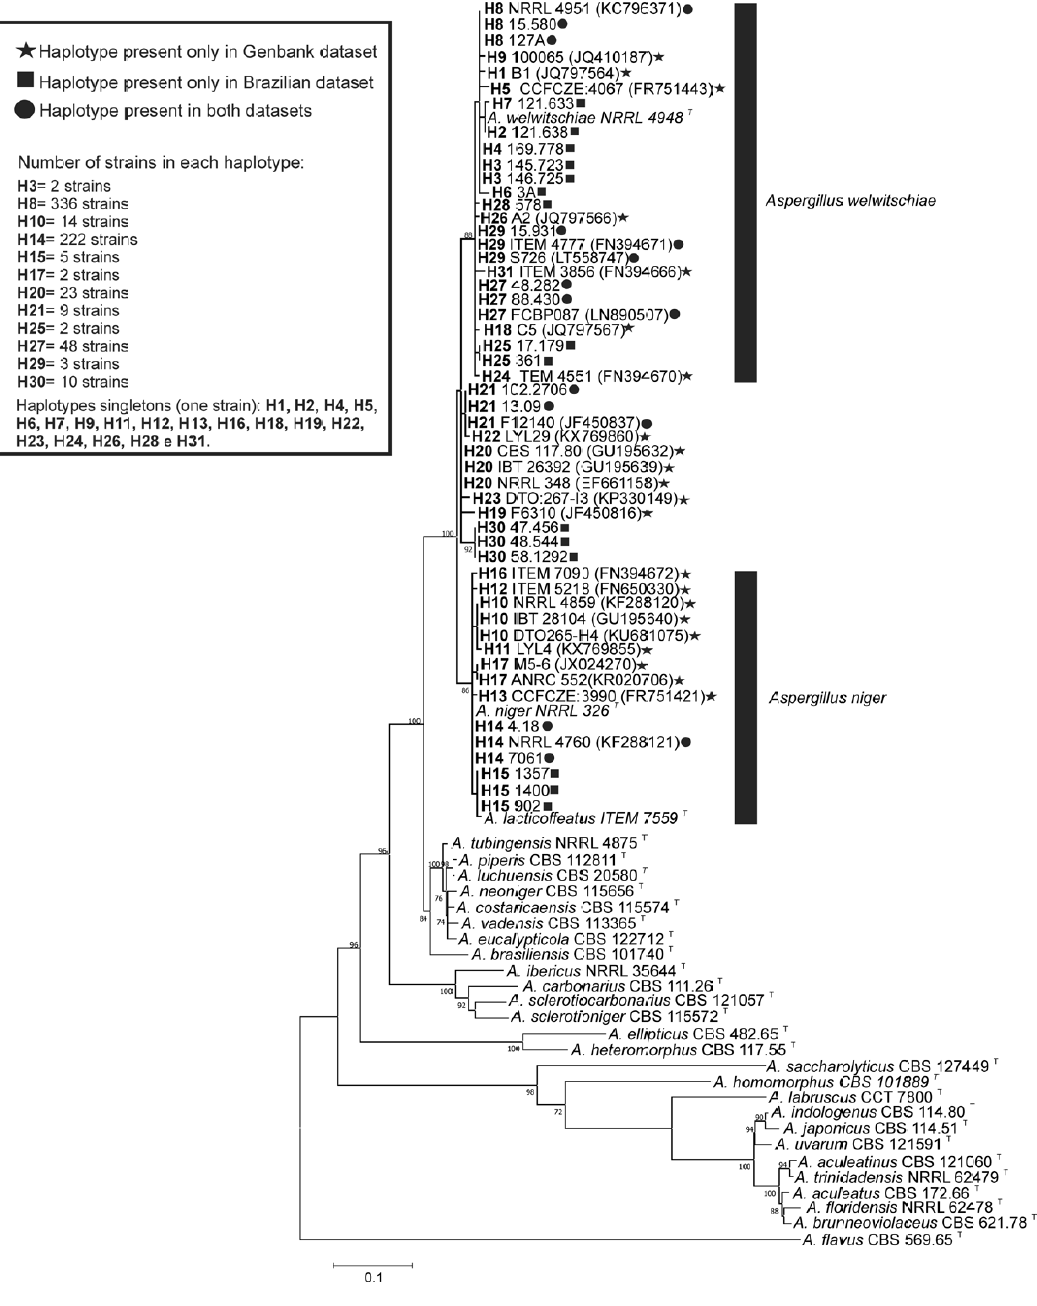
Figure 1. Maximum Likelihood tree of Aspergillus section Nigri species and CaM haplotypes of A. niger clade species. Only bootstrap ≥ 70% are shown. Aspergillus flavus is the outgroup. T superscript = Type